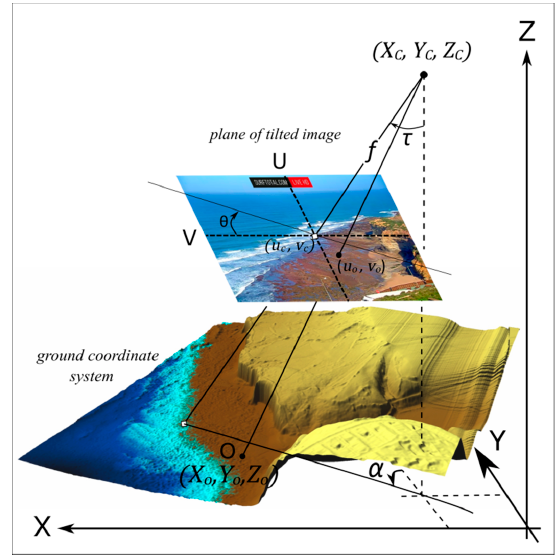
Figure 1. Geometry of space resection. Relationship between the real-world point ( X O , Y O , Z O ), the image point ( u o , v o ), camera focal length f, camera optical center ( X C , Y C , Z C ) and camera rotation angles (azimuth α ; tilt τ and roll θ ). Adapted from